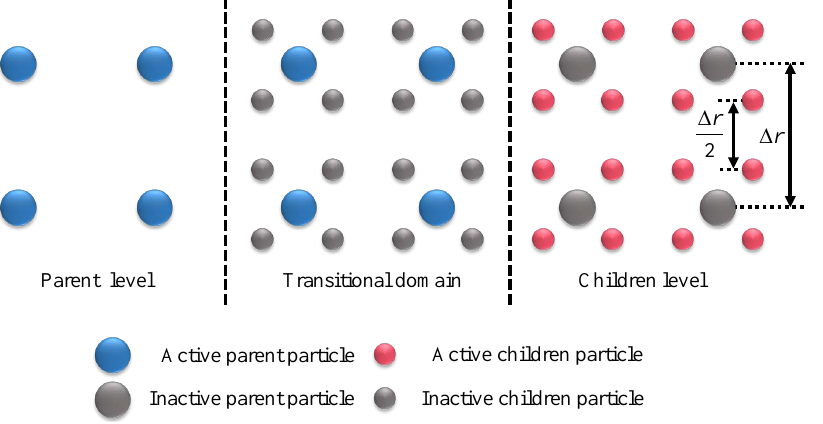
Figure 21. The schematic diagram of Chiron’s APR [244].